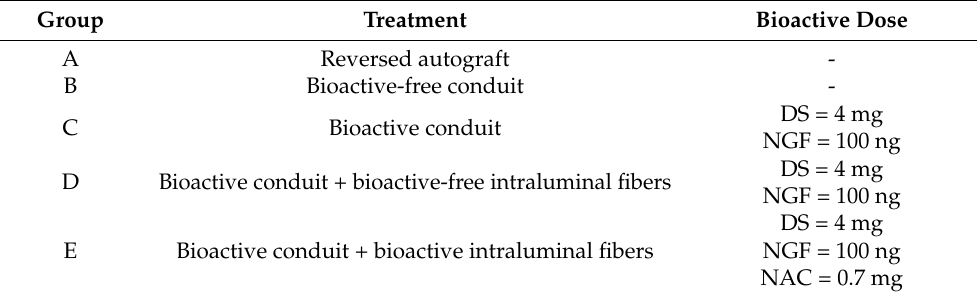
Table 2. Animal groups and type of treatment received over 4 weeks ( n =